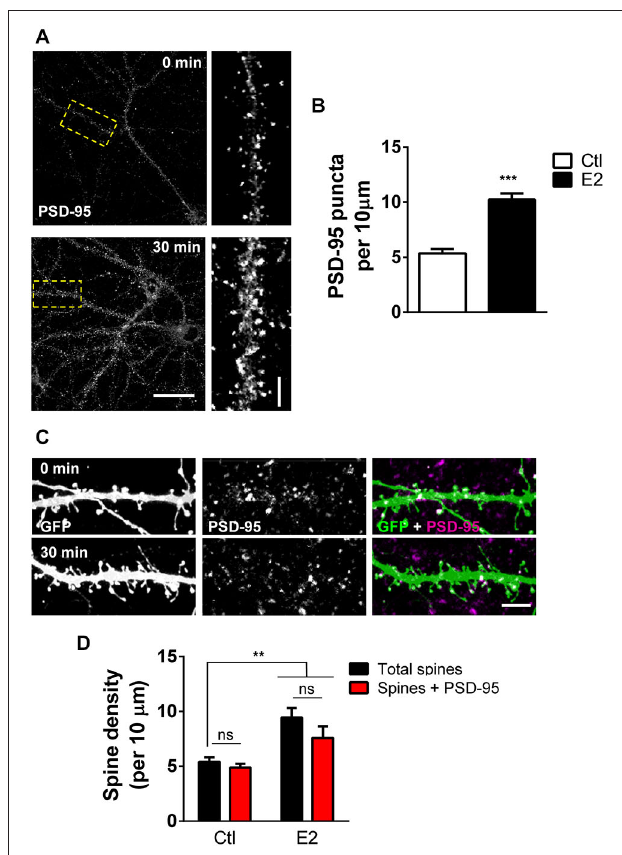
FIGURE 1 | E2 rapidly recruits PSD-95 to nascent spines. (A) Primary cortical neurons (DIV 25) processed for PSD-95 immunostaining following treatment with 10 nM E2 or vehicle (30 min). Yellow dashed box denotes section of dendrite magnified in insets. (B) Quantification of puncta linear density in neurons from (A) reveals an increase in overall PSD-95 expression after E2 treatment ( ∗∗∗ p < 0.001; n = 10–12 cells per condition). (C,D) Representative confocal image of dendritic spines on secondary dendrites from eGFP expressing primary cortical neurons (DIV 25) co-stained for PSD-95. Treatment with E2 for 30 min increased the number of dendritic spines containing PSD-95. ( ∗∗ p < 0.01; n = 13 cells per condition). Scale bar = 50 µ m (A) ; 5 µ m ( A , inset) and (C)